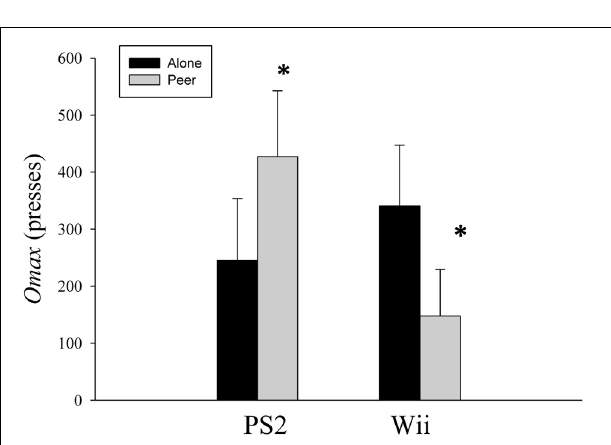
FIGURE 3 | Mean ± s.e.m. for O max social by gaming conditions. Sedentary video game significantly increased ( p = 0 . 05) from the alone to the peer condition, while scores for the “exergame” significantly decreased ( p = 0 . 04) from alone to the peer condition. ∗ Above the grey bar on the left = a significant ( p = 0 . 05) increase in motivation for PS2 (sedentary game/Playstation 2™) from the alone condition to the peer condition. ∗ Above the grey bar on the right = a significant ( p = 0 . 04) decrease in motivation for the Wii (exergame/Nintendo Wii™) from the alone condition to the peer